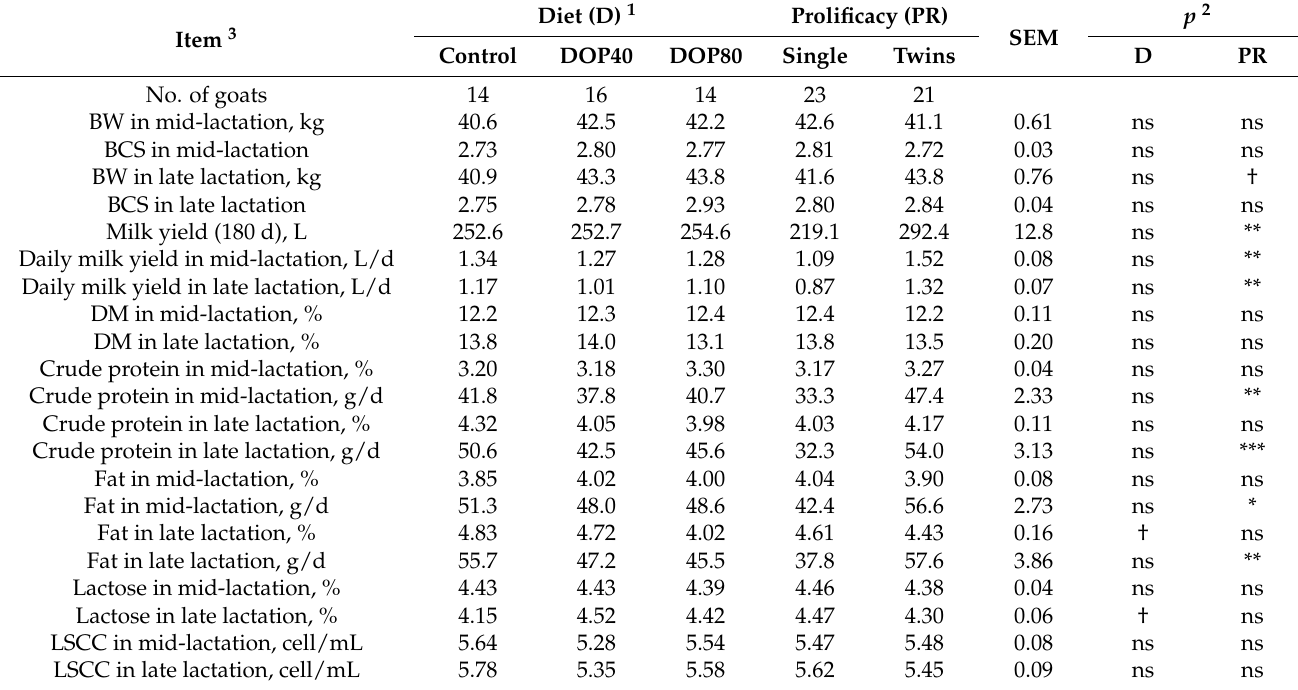
Table 2. Milk performance during the entire lactation period of goats fed the experimental diets.